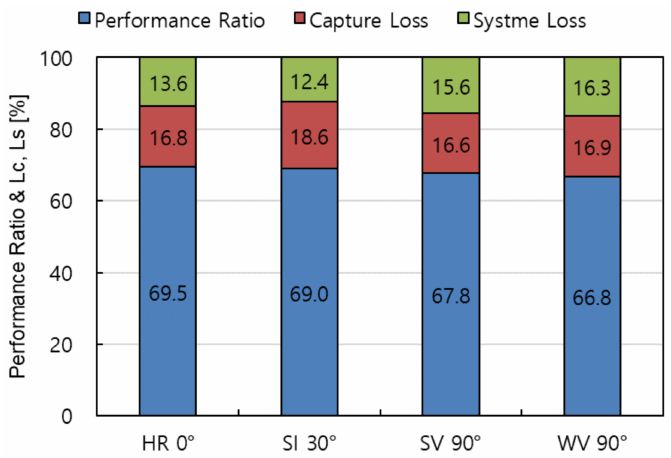
Figure 4. Performance ratio and loss of each